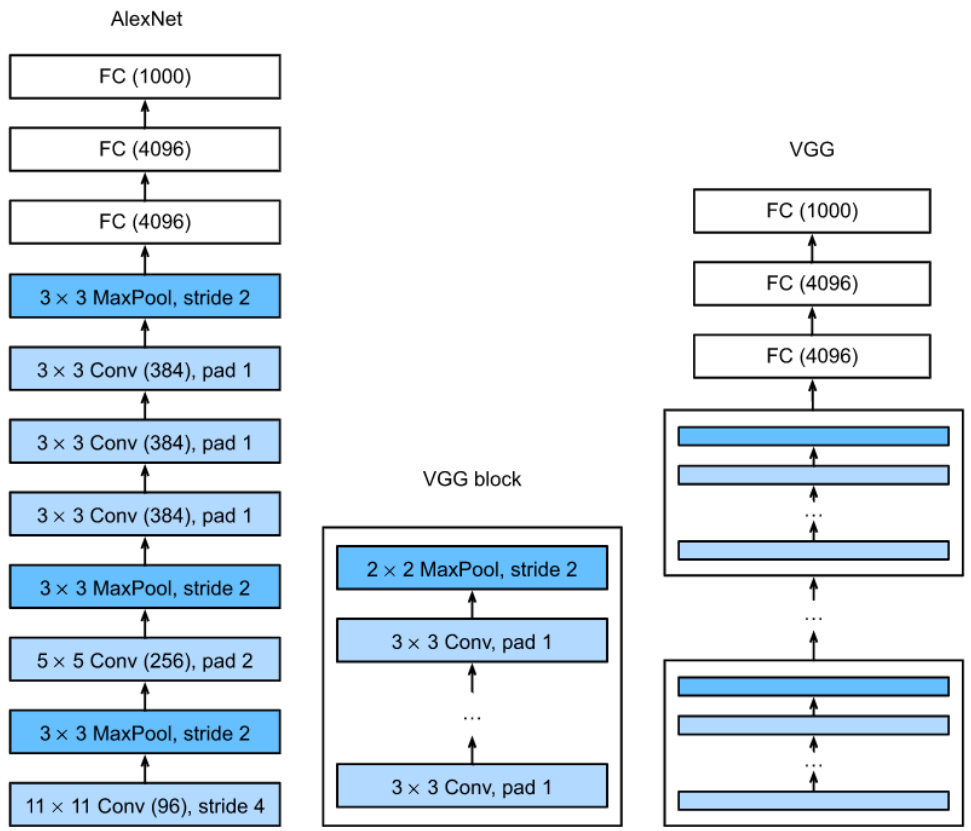
Figure 4. The model structure for VGGNet